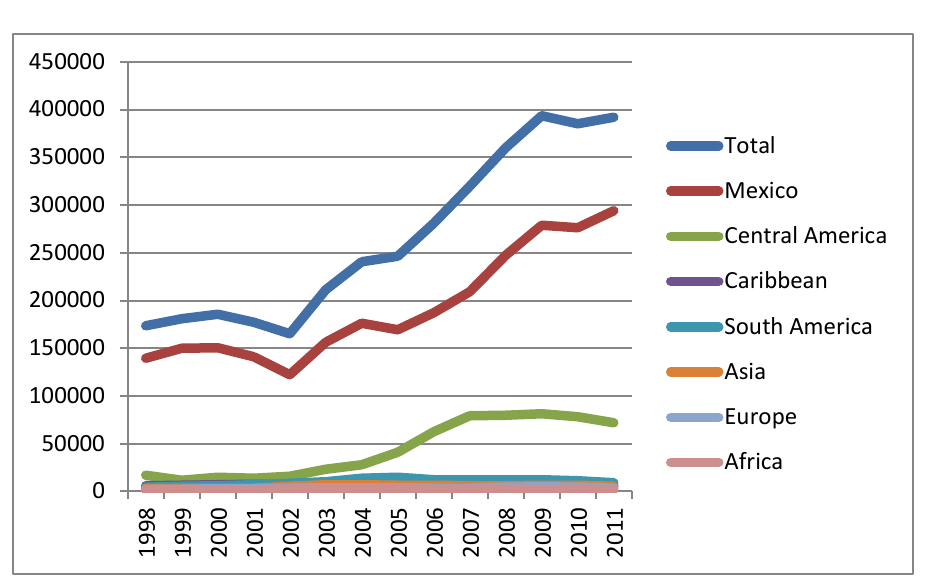
Figure 3: Total Removals and Removals by Region,